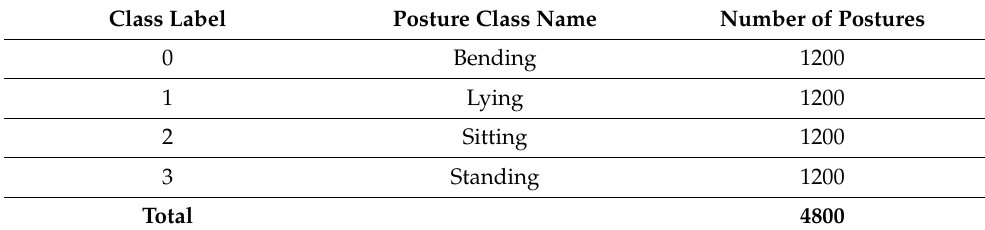
Table 3. Overview of Silhouettes for HPD and Class